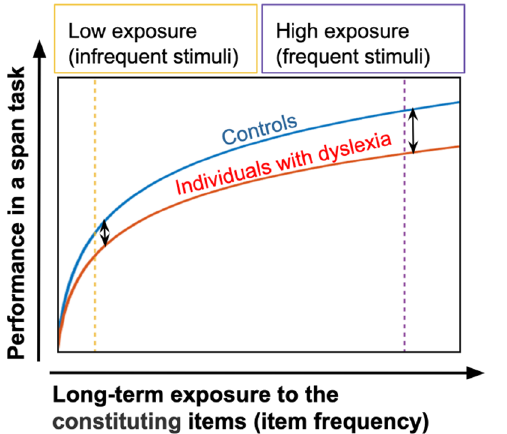
Figure 1. An illustration of the predicted performance in a span task as a function of exposure to the items that are used in the span task. Since the rate of increase is shallower for individuals with dyslexia (slower learning), group difference is expected to increase with exposure. Therefore, group difference is expected to be larger for frequent (right dashed line) than for infrequent (left dashed line) stimuli. Figure adapted from 13